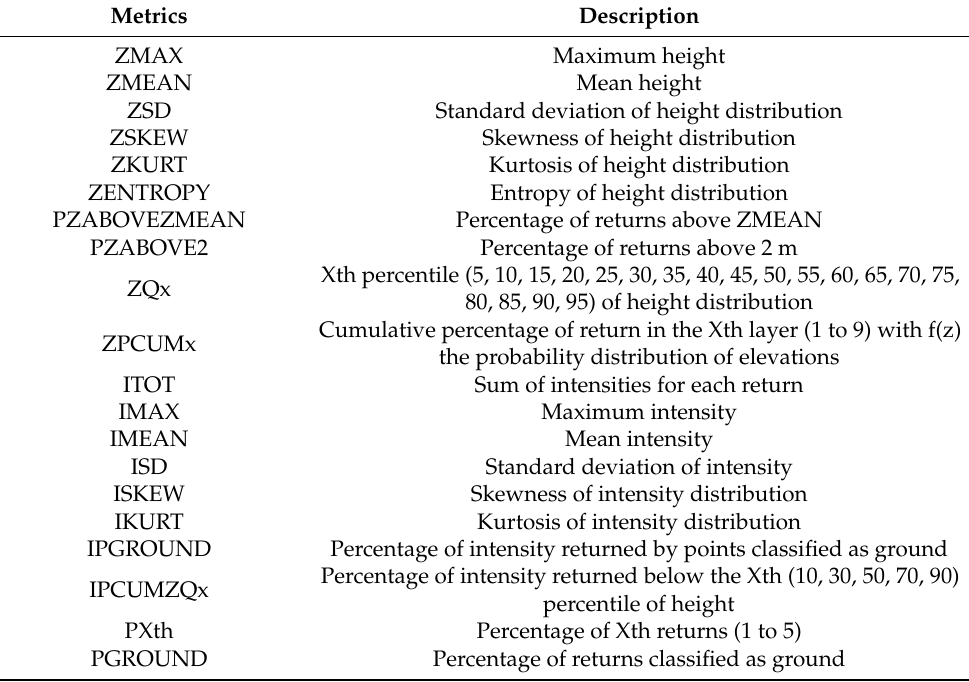
Table 2. Light detection and ranging (LiDAR) metrics extracted from normalized point clouds. Metrics